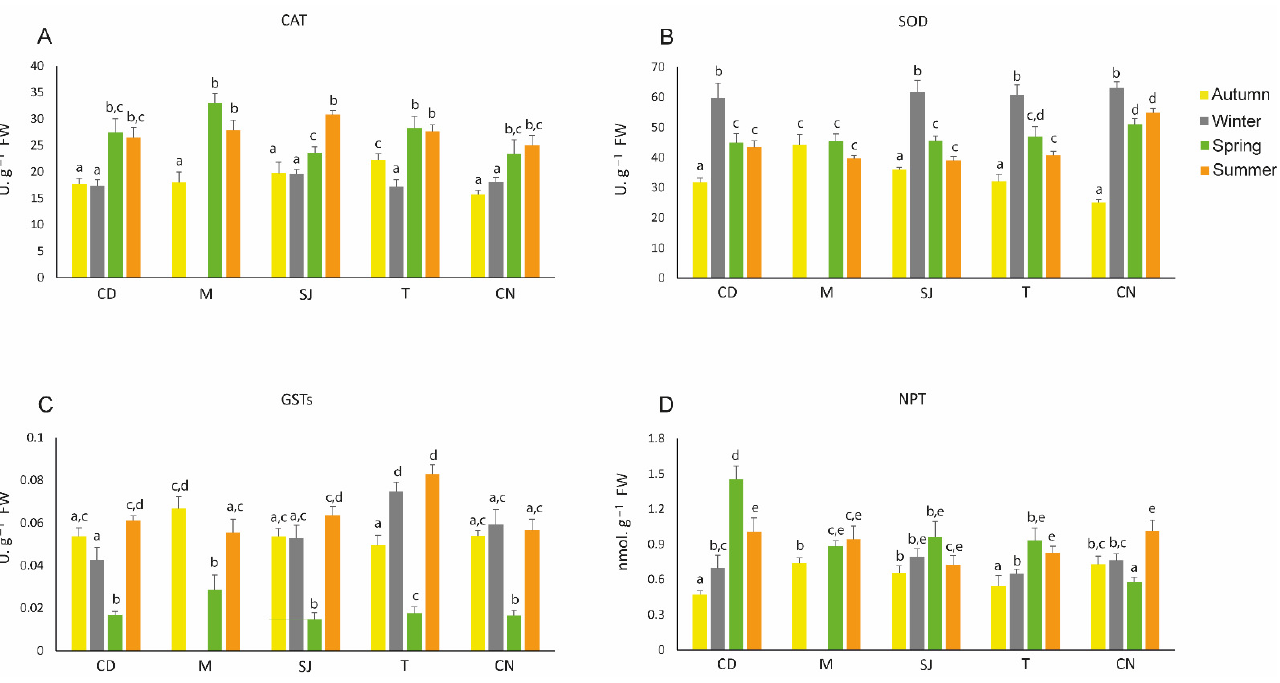
Figure 5. Antioxidant defences: ( A ) catalase (CAT), ( B ) superoxide dismutase (SOD), ( C ) glutathione S-transferases, and ( D ) non-protein thiols (NPTs) measured in Diopatra neapolitana in autumn 2018 and winter, spring, and summer 2019. Comparison between different seasons at the same site. Letters (a–e) represent significant differences between areas and seasons ( p ≤ 0.05). CD: Cale do Ouro; M: Murtosa; SJ: São Jacinto; T: Torreira; CN: Costa Nova. Site M has no winter data.